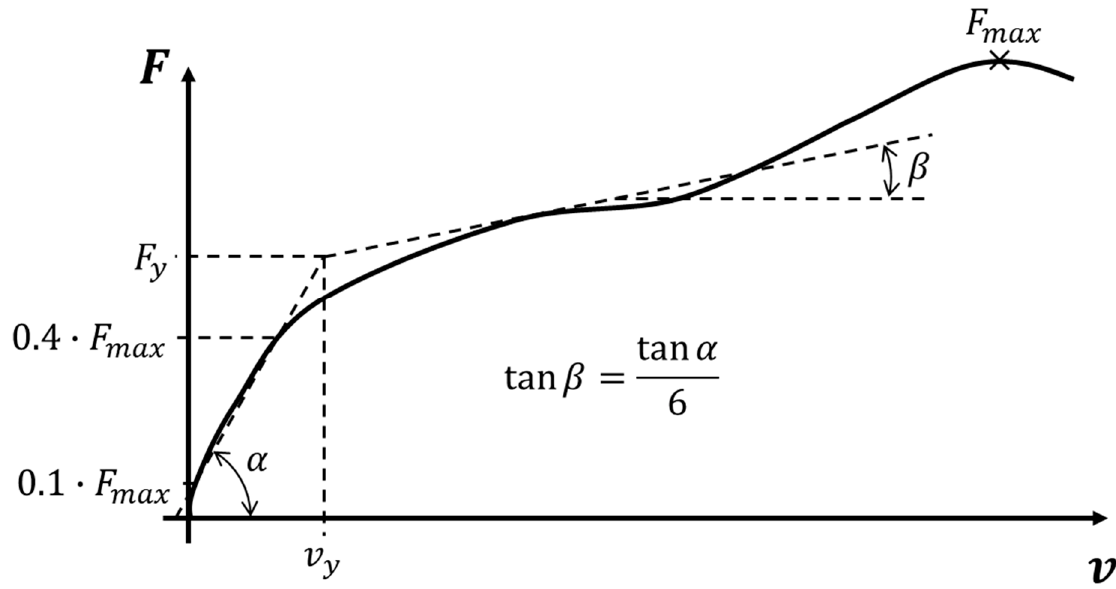
Figure 4. Definition of yield values for load–slip curve (reproduced from [28]).